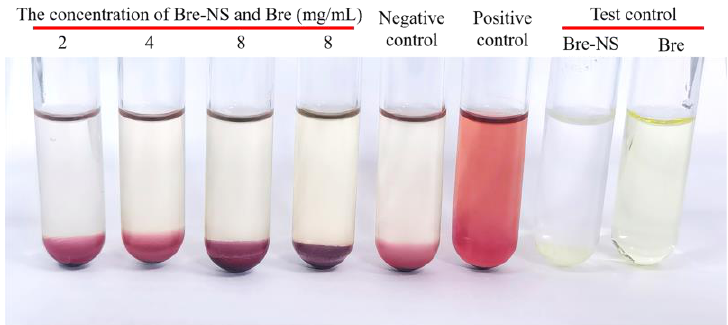
Figure 8. Hemolysis test results of the Bre-NS and commercially available Bre injection at different dilution ratios.